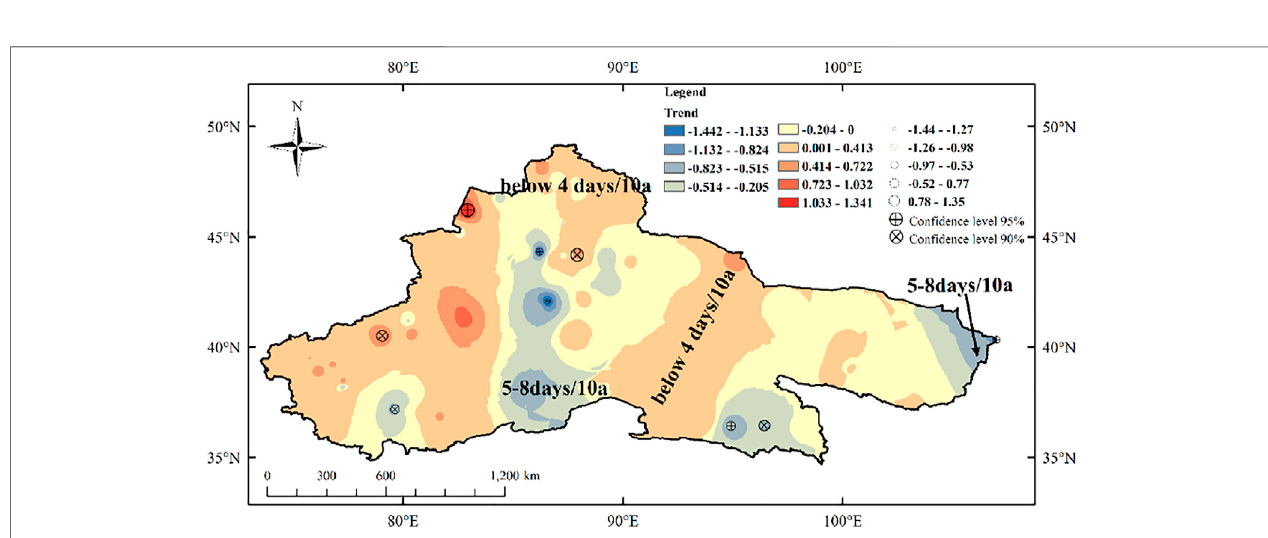
FIGURE 5 | Interannual variation of the spatial pattern of the extreme precipitation concentration period (unit: ° /a).